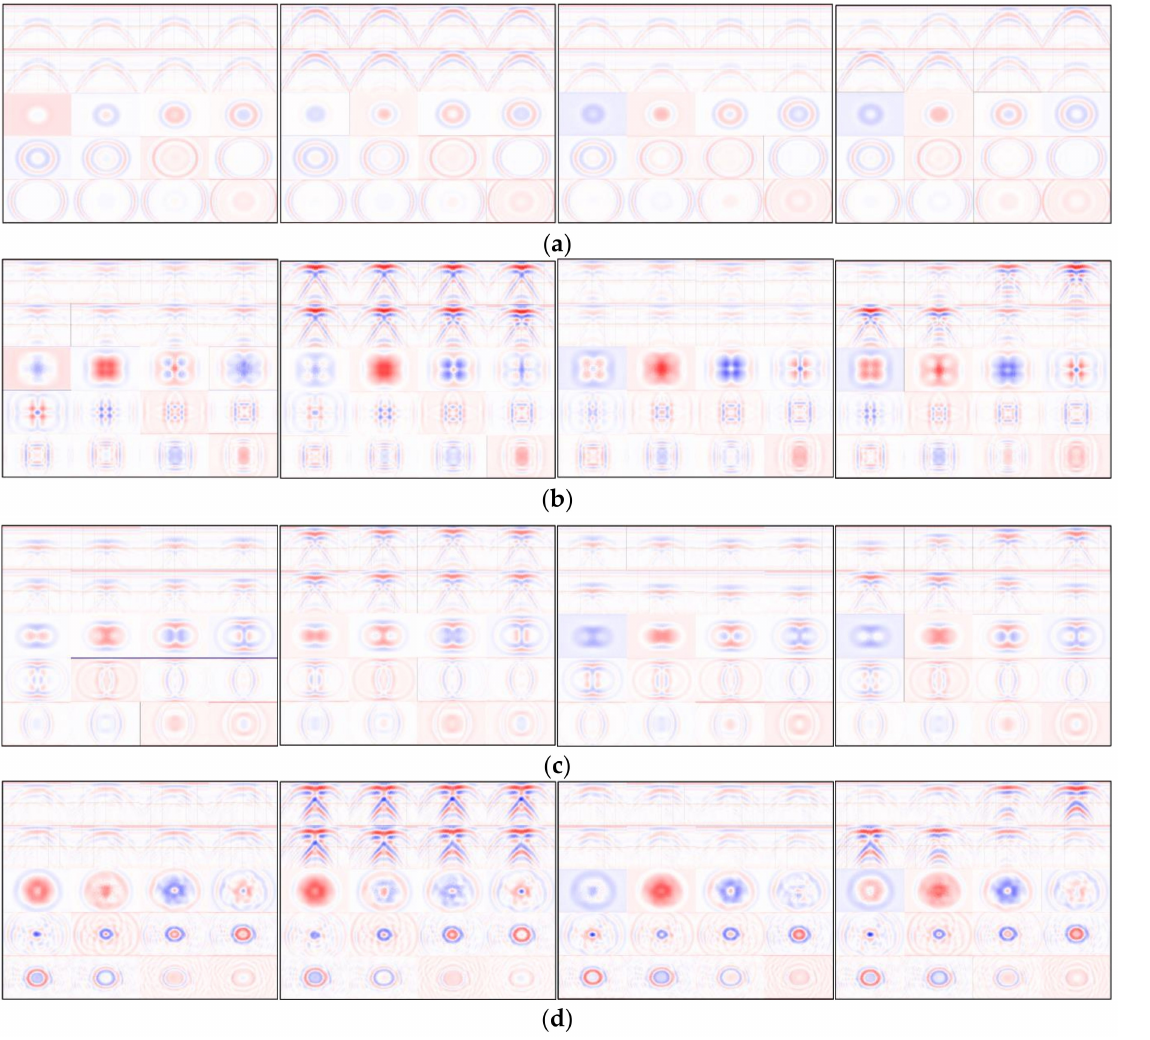
Figure 13. Representative 2D GPR images of cavities: ( a ) spherical, ( b ) rectangular, ( c ) cylindrical, and ( d ) irregular